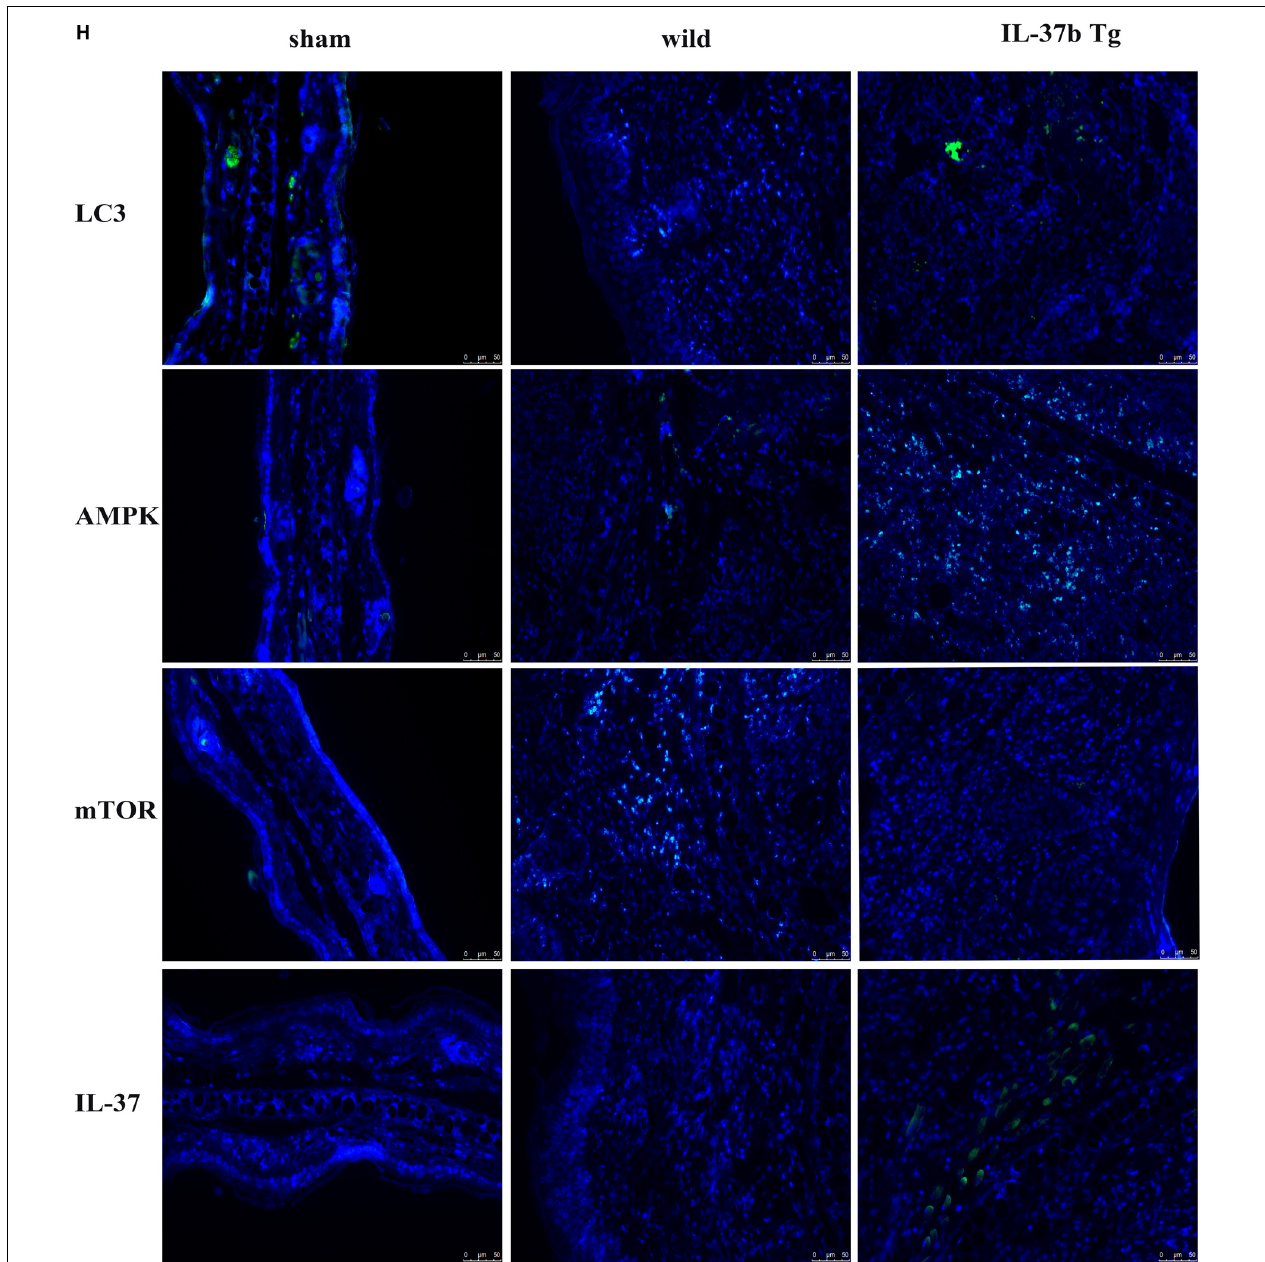
FIGURE 6 | Autophagy mechanisms induced by IL-37b in AD. Autophagy related representative metabolites between different groups with Log10 of peak intensity. (A) Adenosine 5’-monophosphate. (B) 3-methyladenine. (C) Melatonin. (D) Purine. (E) D- α -Hydroxyglutaric acid. A2, stool samples of wild type mice at day 15 with MC903 inducing AD model; B2, stool samples of IL-37 Tg mice at day 15 with MC903 inducing AD model. (F) Western blot analysis of autophagy related proteins in ear tissue of wild type mice and IL-37b Tg mice, upon MC903 stimulation for 16 days and (G) Quantification of AMPK, mTOR, IL-37b levels normalized to β -actin and LC3II/LC3I ratio. (1: sham group, wild type mice without MC903 stimulation; 2: IL-37b non-AD group, IL-37b mice without MC903 stimulation; 3: wild type AD group, wild type mice with MC903 stimulation; 4: IL-37b Tg AD group, IL-37b Tg mice with MC903 stimulation). (H) Immunostaining assessment of LC3, AMPK, mTOR, and IL-37 expression in ear tissue of wild type mice and IL-37b Tg mice, upon MC903 stimulation for 16 days. Bar charts are shown as mean ± SEM ( n = 6 mice). * P < 0.05 and ** P < 0.01 when compared between the denoted